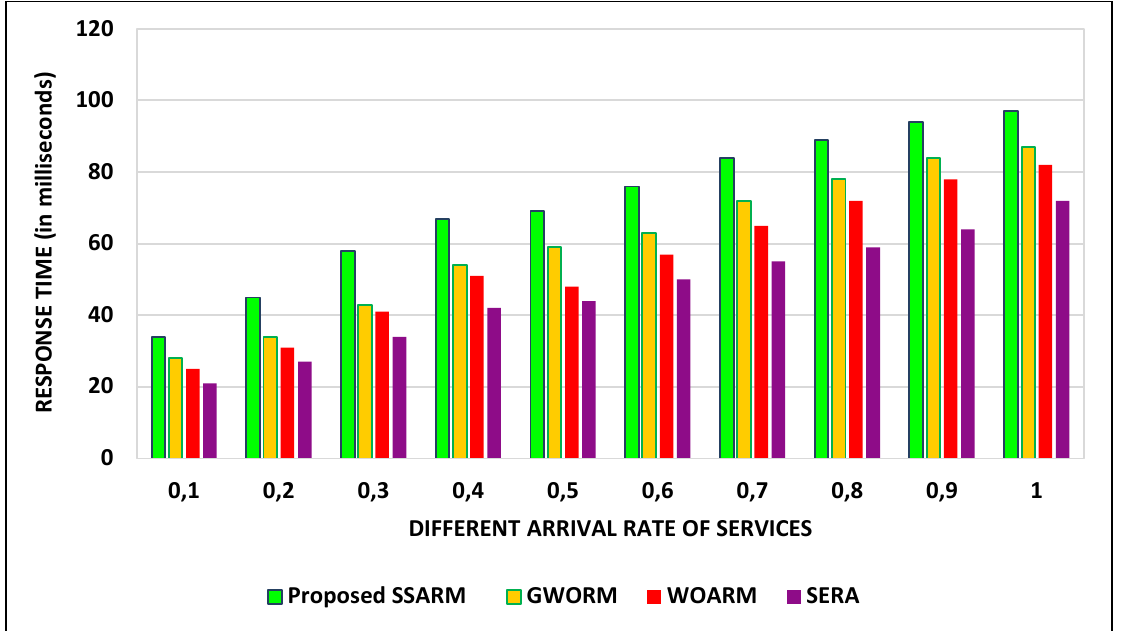
Figure 1. Proposed SSARM: Response Time with Different Service Arrival